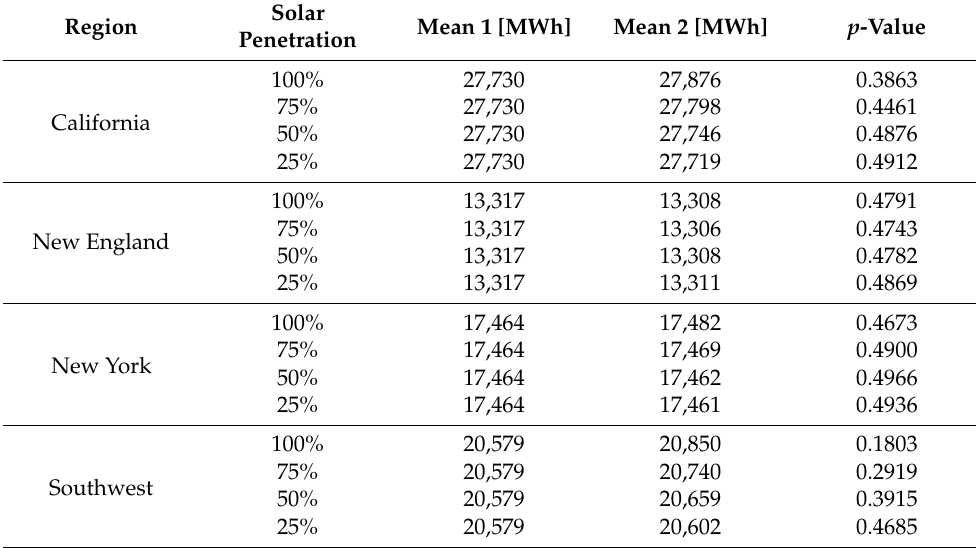
Table 10. Hypothesis 4— t -test results by region and level of solar penetration.